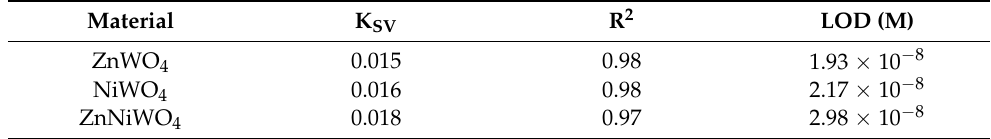
Figure 11. Stern – Volmer plots for varying p-NA concentrations in methanol for ( a ) ZnWO 4, ( b ) Figure 11. Stern–Volmer plots for varying p-NA concentrations in methanol for ( a ) ZnWO 4 , NiWO 4, and ( c ) ZnNiWO 4 NPs. ( b ) NiWO 4 , and ( c ) ZnNiWO 4 NPs. Table 2. Stern – Volmer parameters calculated for ZnWO 4 , NiWO 4, and ZnNiWO 4 NPs. Table 2. Stern–Volmer parameters calculated for ZnWO 4 , NiWO 4 , and ZnNiWO 4